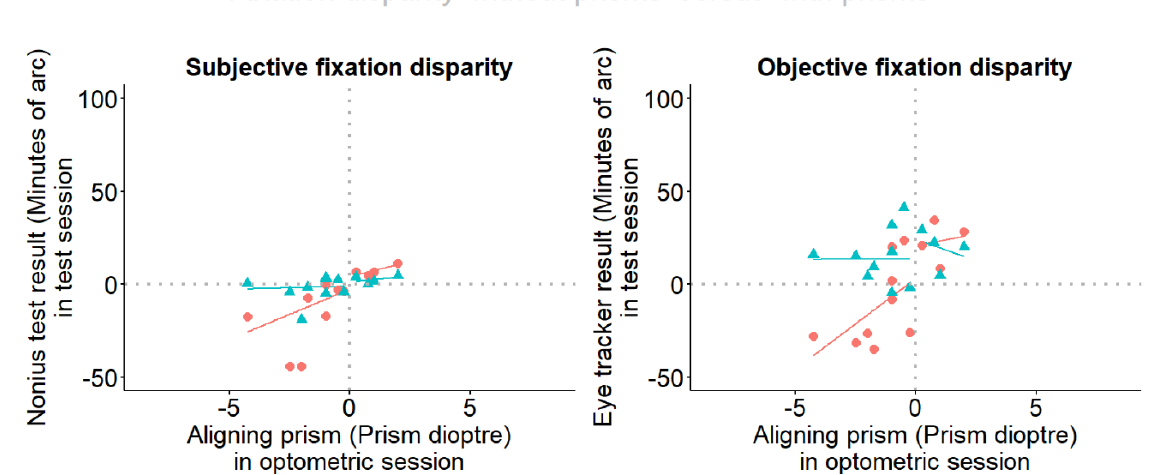
Figure 3: Fixation disparity depending on the aligning prism. Red dots and lines refer to the situation without prism, blue triangles and lines refer to the situation when prisms are worn. The fixation disparity has a negative sign for exo, under- convergent states and a positive sign for eso, over-convergent states. The aligning prism has a positive sign for base-out prisms and a negative sign for base-in prisms.. (a) Subjective fixation disparity is given by the nonius offset of the dichoptic targets and (b) objective fixation disparity is given by the eye recording of the vergence error. The robust regression lines refer to separate analyses for base-in and base-out